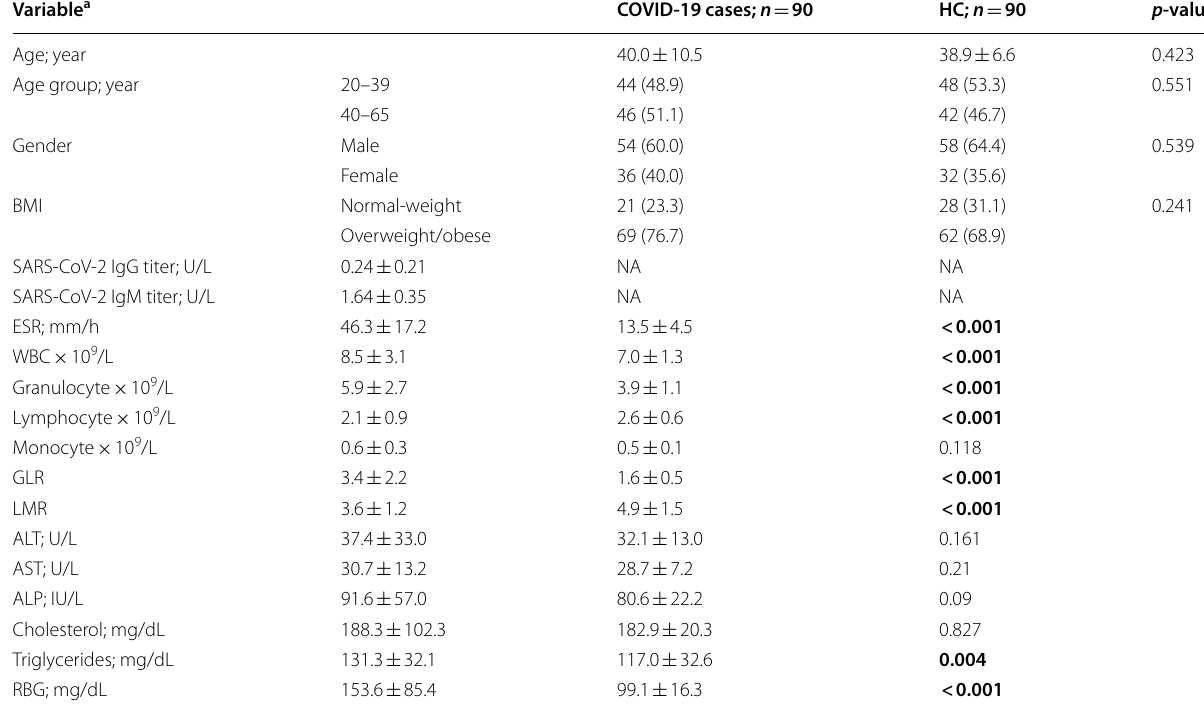
Table 1 Baseline data for COVID-19 cases and